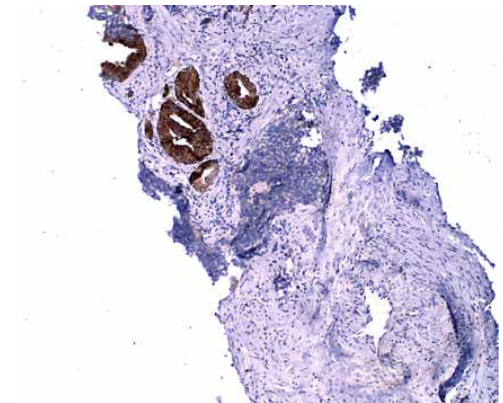
Figure 7 - High grade neuroendocrine carcinoma with strong positivity for chromogranin immunostain.